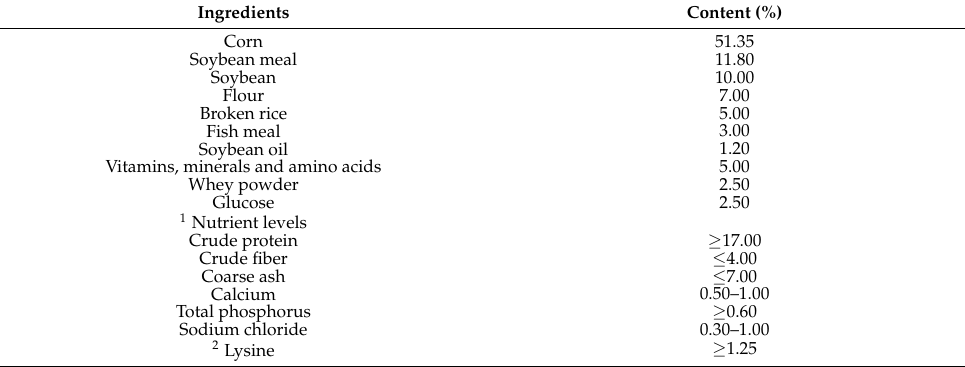
Table 1. Ingredients and nutrient levels of the experimental